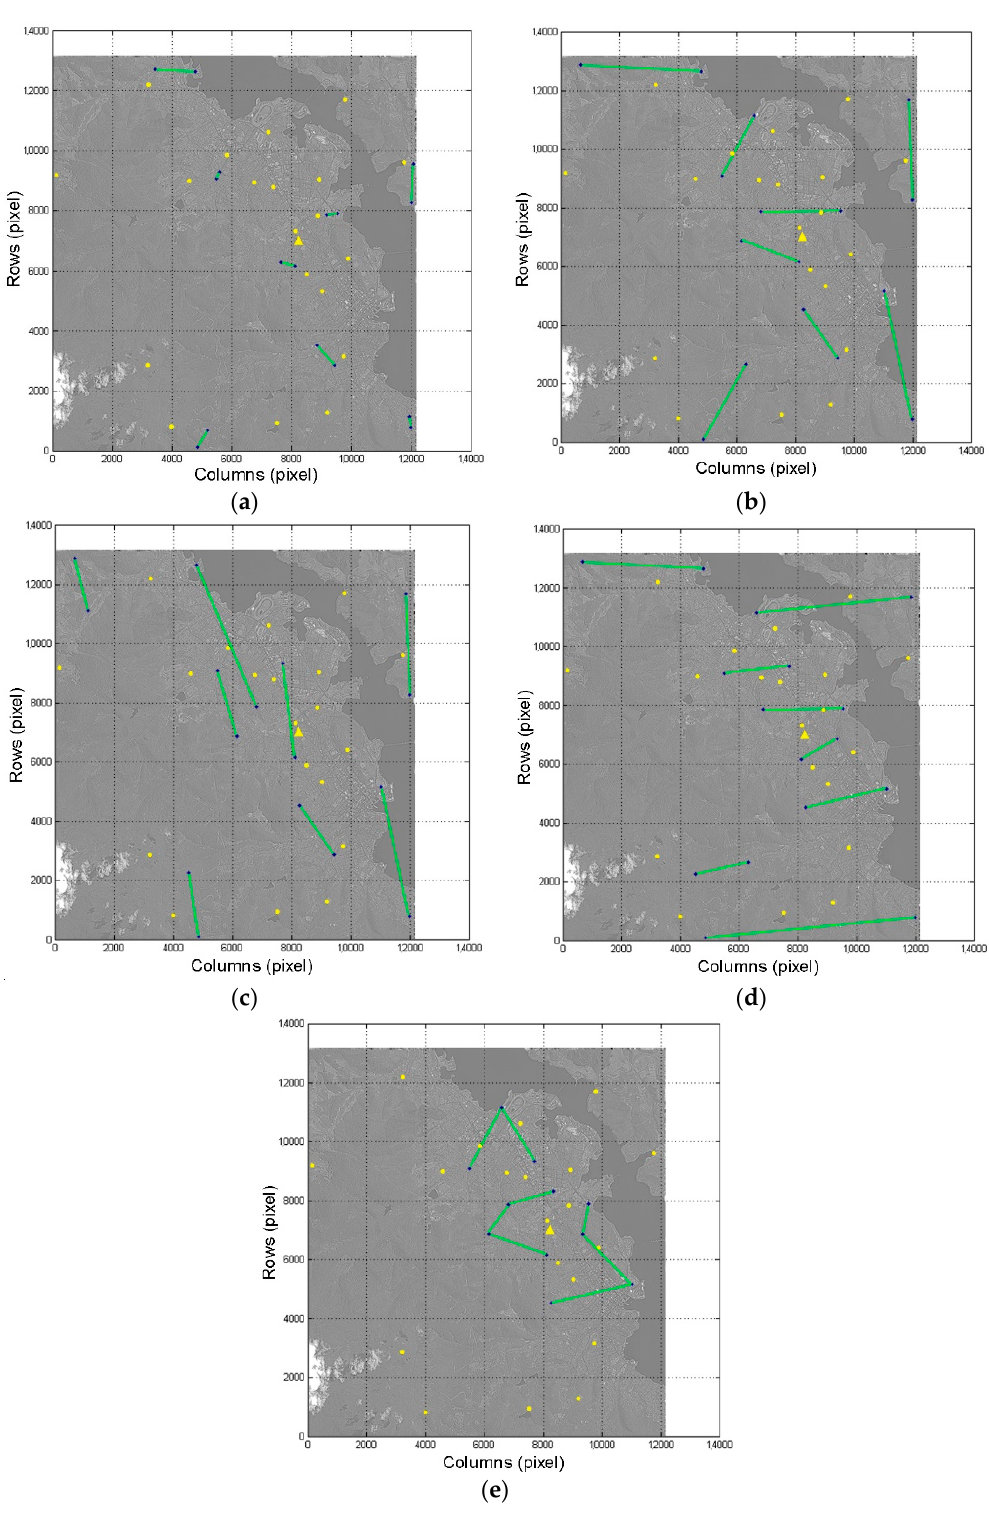
Figure 7. Distributions of the control conditions of Control Schemes VII to XI on dataset IKONOS_HB: ( a ) control conditions of Control Scheme VII; ( b ) control conditions of Control Scheme VIII; ( c ) control conditions of Control Scheme IX; ( d ) control conditions of Control Scheme X and ( e ) control conditions of Control Scheme XI. In each subfigure, green line segments represent control lines; blue dots represent control points, which construct the control lines; yellow triangles represent single GCP; and yellow dots represent check points.